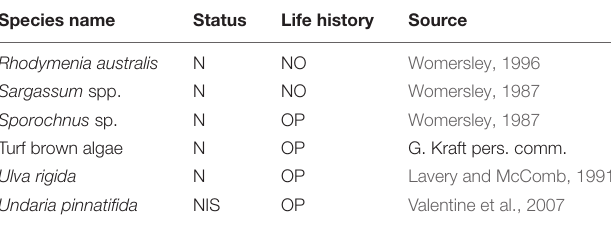
TABLE 1 | Summary of taxa found during the experiment and the information source used to classify them as native (N) or non-indigenous (NIS),